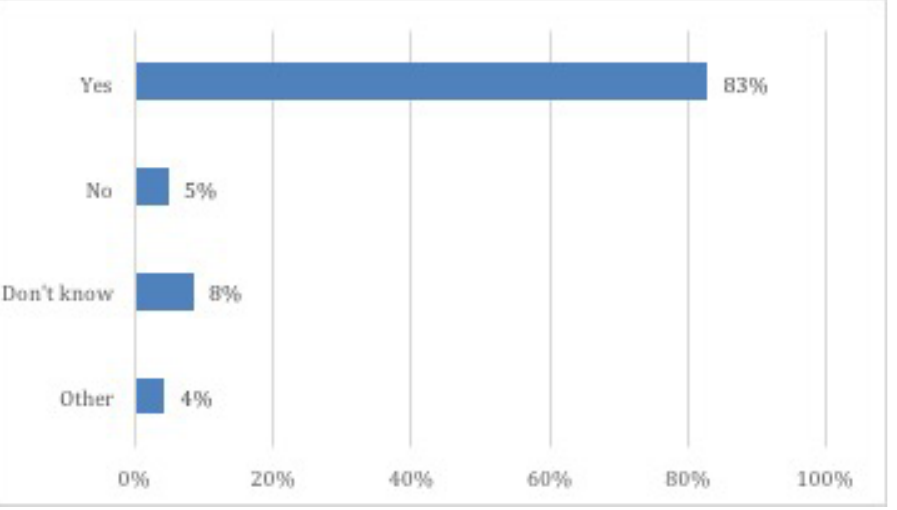
Figure 9: Results of the ‘2015 Danish detectorists survey’. Detectorists were asked whether they would be willing to upload finds in a publicly accessible online scheme (provided that exact findspots are hidden for members of the public and only accessible for archaeologists and